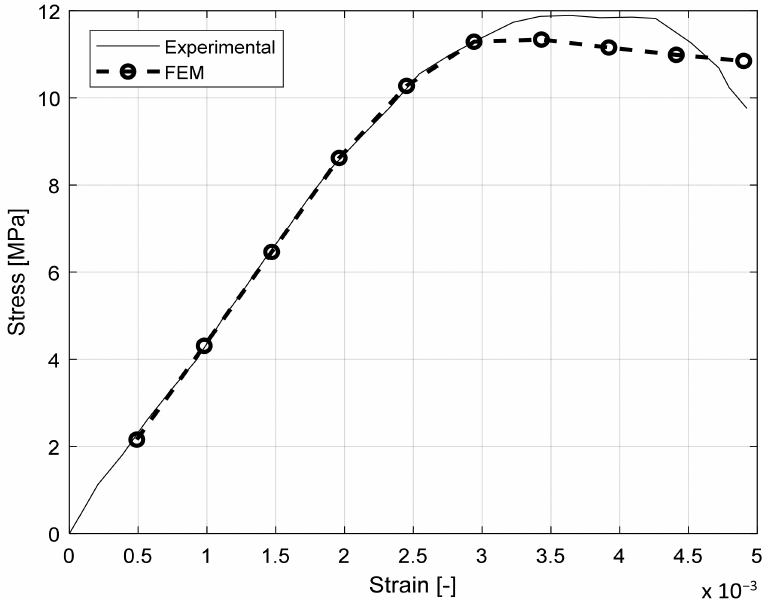
Figure 5. Stress strain experimental observation vs. FE model